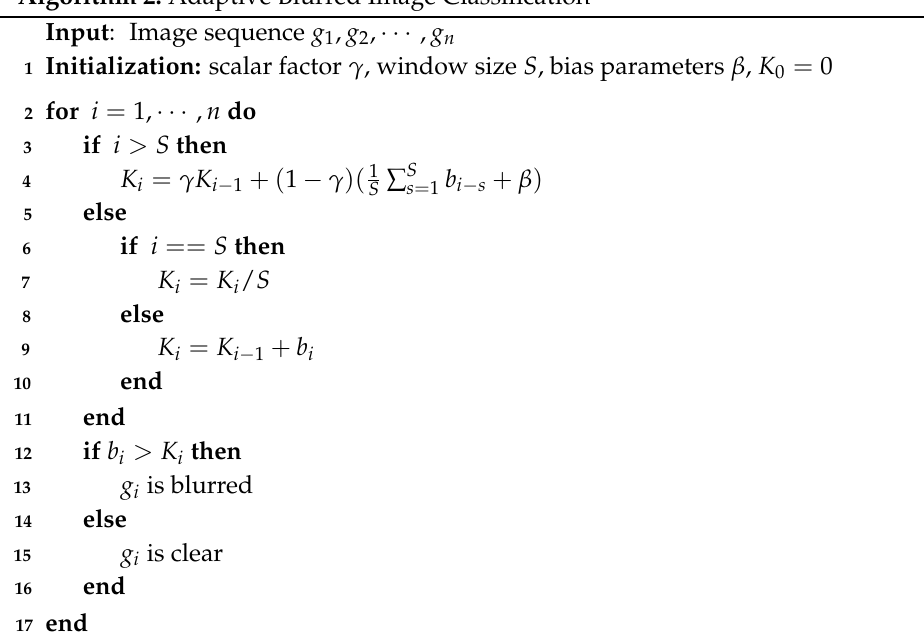
Algorithm 2: Adaptive Blurred Image